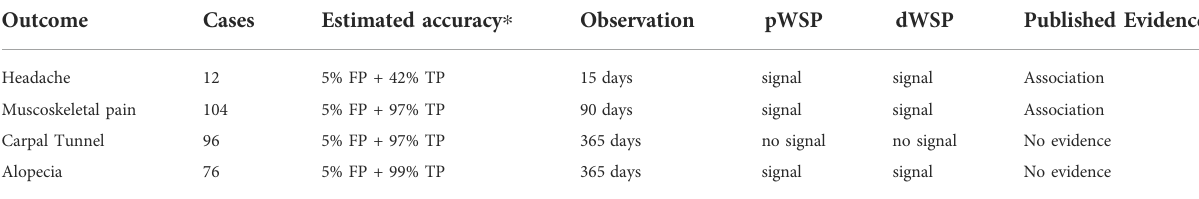
TABLE 4 Signal raised from the pWST and dWSP to a cohort of 19,817 women prescribed with biphosphonates (THIN dataset). p Mean simulation valuesbasedonanoccurrencearoundthe fi rstquarteroftheobservationperiodandbasedonthenumberofobservations.TP,Truepositive